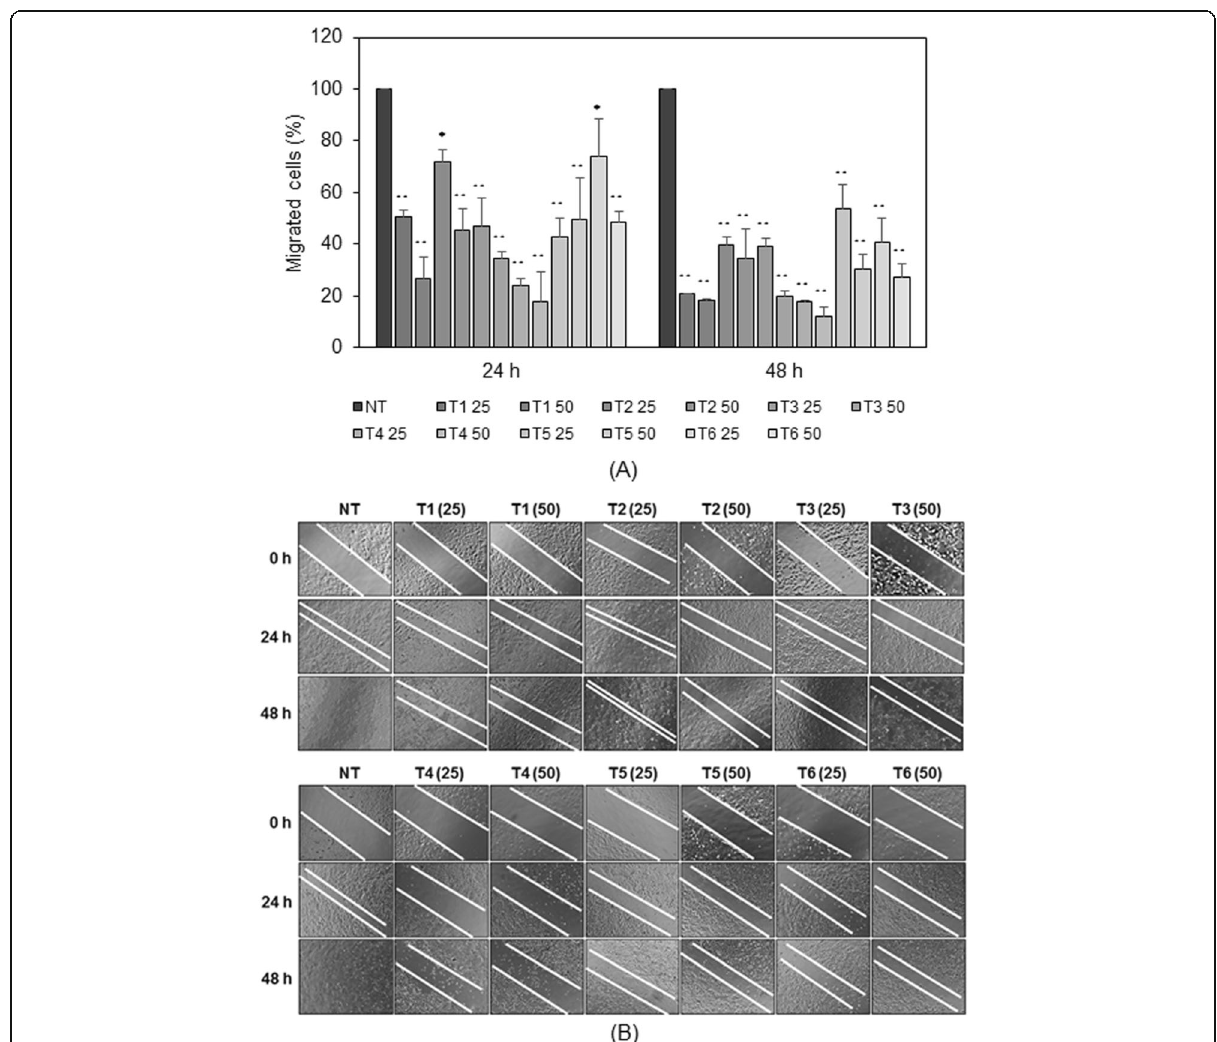
Fig. 3 Antimetastatic effects of plant extract against Hep3B cells ( a , b ). Statistical analysis was carried out using one-way ANOVA followed by t test. *Statistically significant between cell lines treatment with extract at * p < 0.05, ** p < 0.001 vs. the